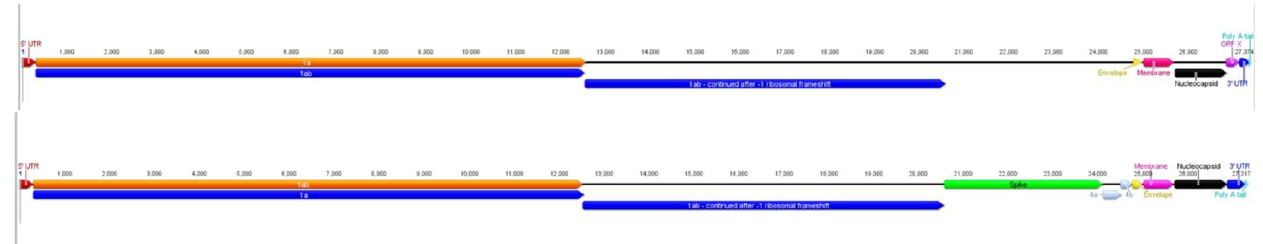
Figure 1. Schematic representation of a comparison between ACoV (top) and the HCoV-229E (bottom) genome. The figure is drawn to scale; open reading frames are